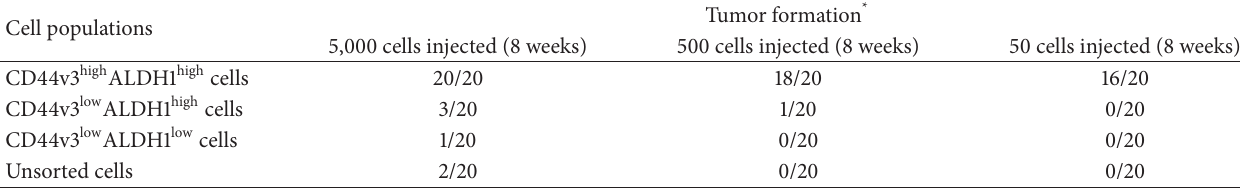
Table 1: Analyses of tumor formation by CD44v3 high ALDH1 high cells, CD44v3 low ALDH1 low cells, CD44v3 low ALDH1 high cells, or unsorted cells subcutaneously injected into NOD/SCID mice.